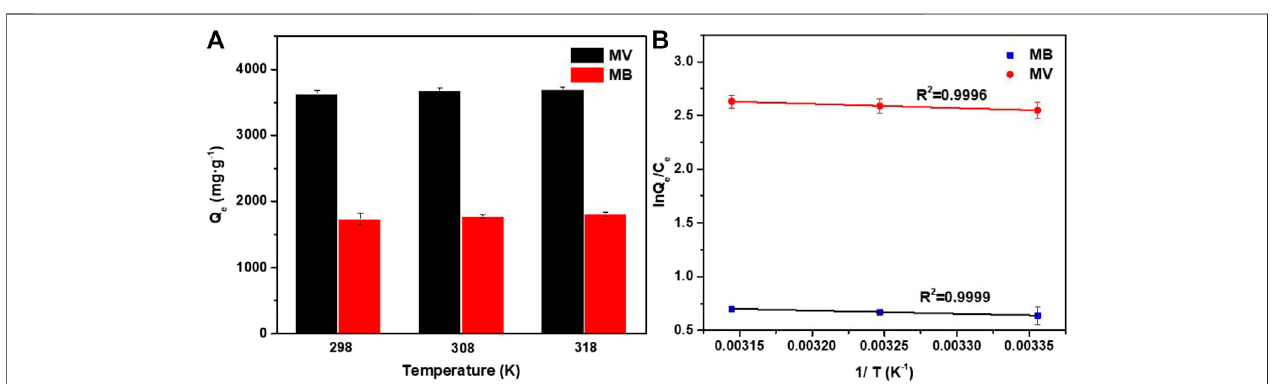
FIGURE7|(A) AdsorptioncapacitiesofPFPCSforMBandMVatdifferenttemperaturewithinitialdyeconcentrationof1,500 mg L − 1 (pH (cid:2) 8). (B) PlotsoflnQe/Ce against 1/T for the adsorption of MB and MV onto the PFPCS.